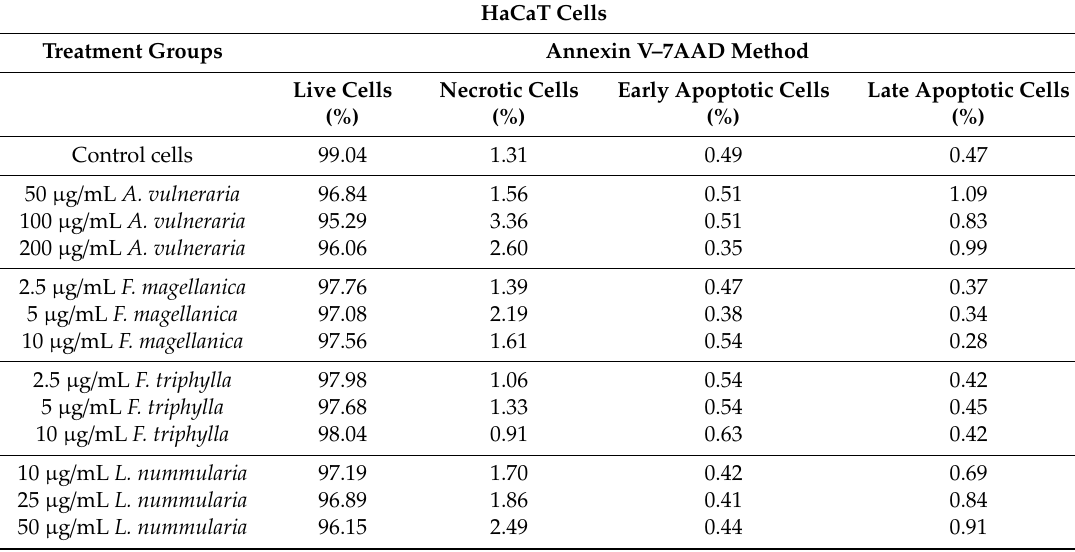
Table 5. Apoptosis–necrosis assay data of HaCaT cells treated with 50% ( v / v ) ethanolic extracts